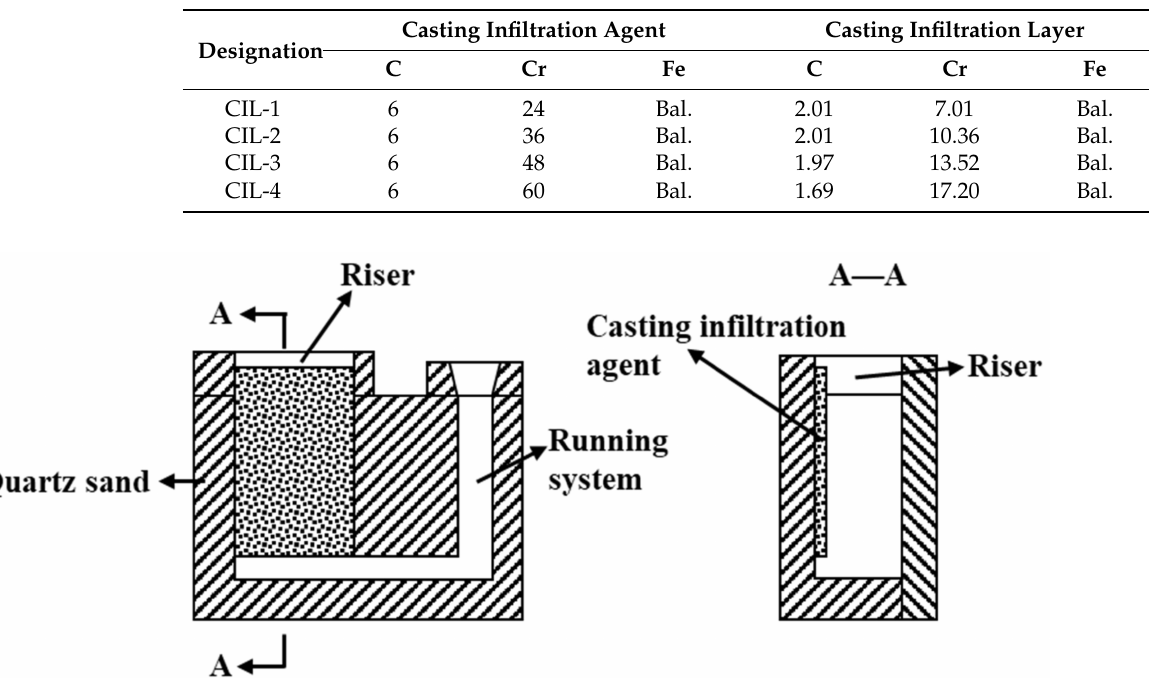
Figure 1. The illustration diagram of the casting infiltration